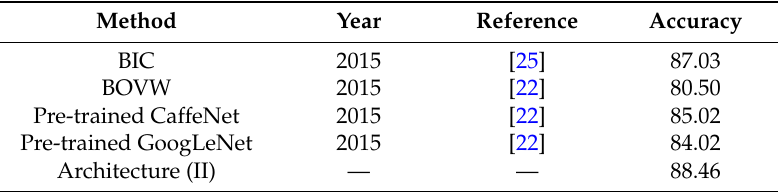
Table 6. Classification accuracy (%) of reference and proposed methods on the Brazilian Coffee Scenes